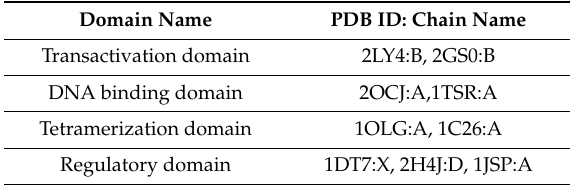
Table 1. List of templates used for modelling p53 structure.